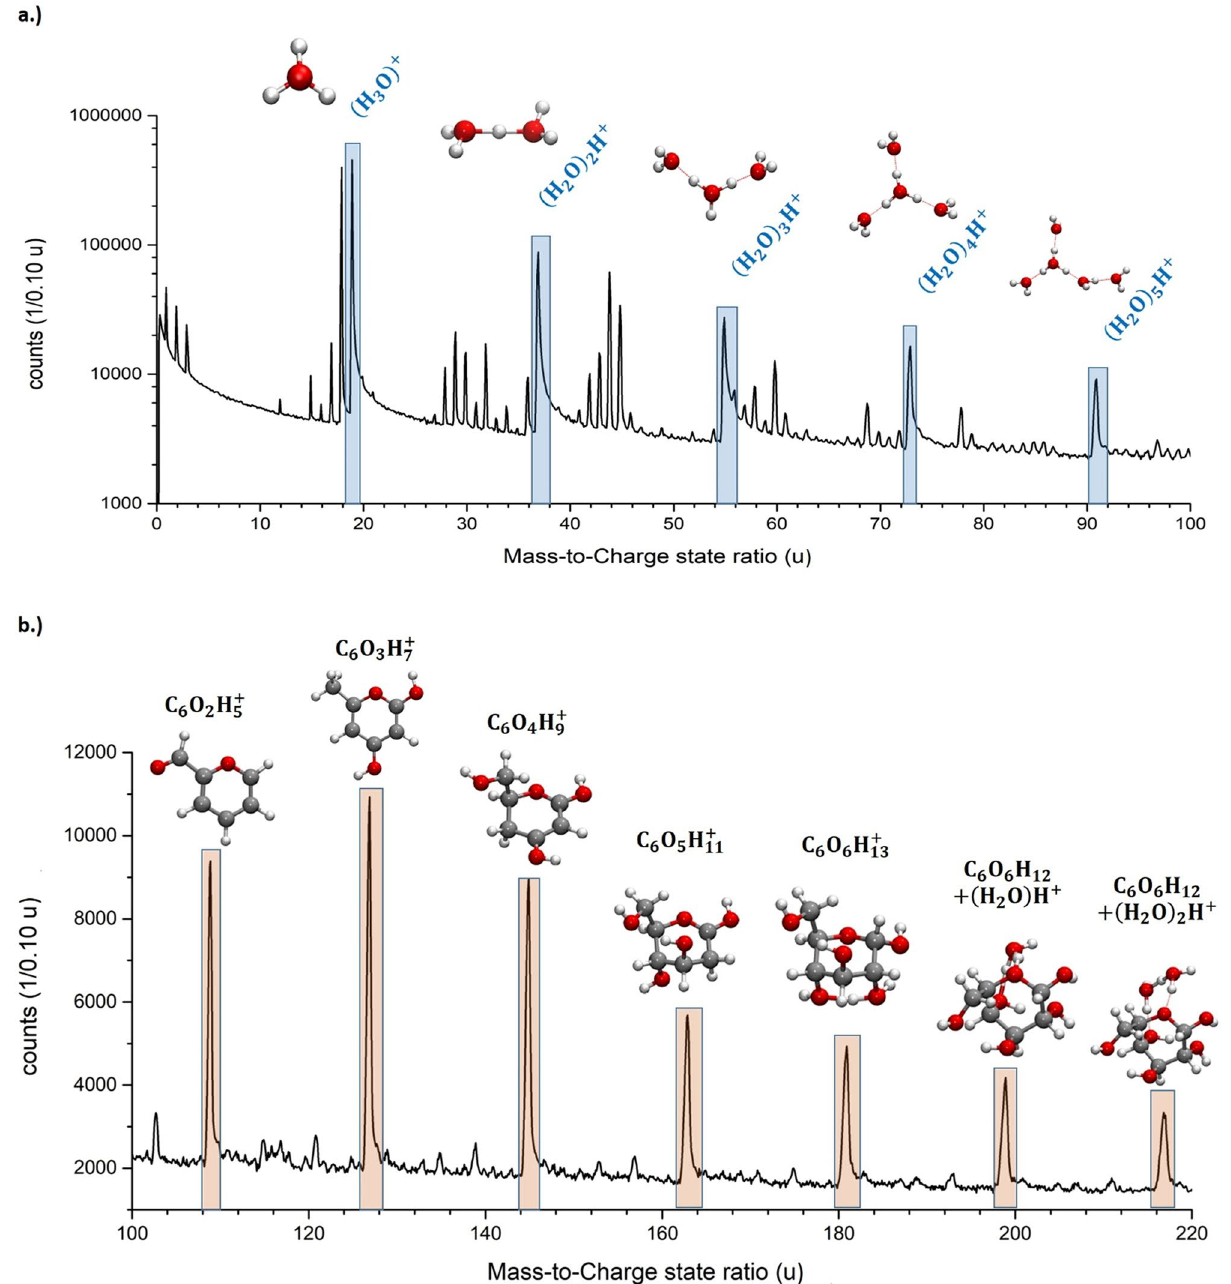
Figure 1. ( a ) Mass spectrum of a supersaturated glucose solution with a mass-to-charge state ratio from 0 to 100 u as logarithmic plot. The protonated water molecules/clusters are highlighted and the respective molecular structure of (H 2 O) n H + with n = 1–5 are shown. ( b ) Mass spectrum of a supersaturated glucose solution with a mass-to-charge state ratio from 100 to 220 u as linear plot. The peaks stemming from glucose from m/z = 91 up to 217 u are marked and the respective molecular structures are